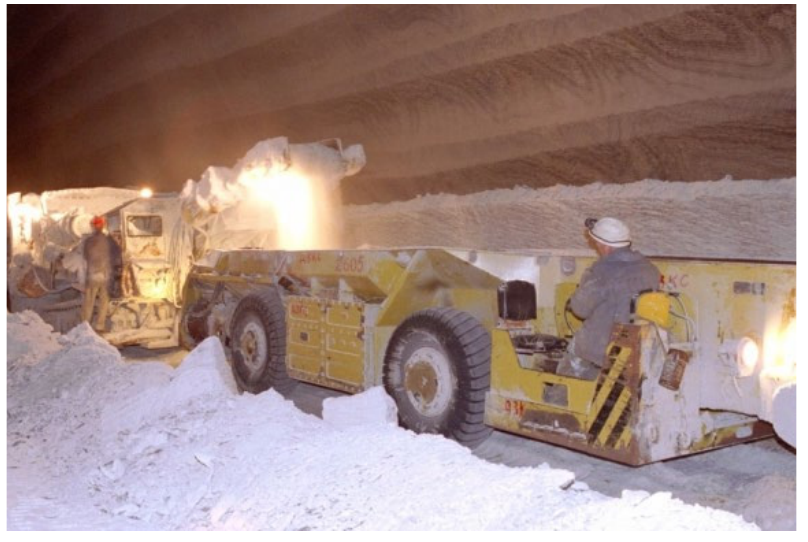
Figure 1. Shuttle car for the mining industry.